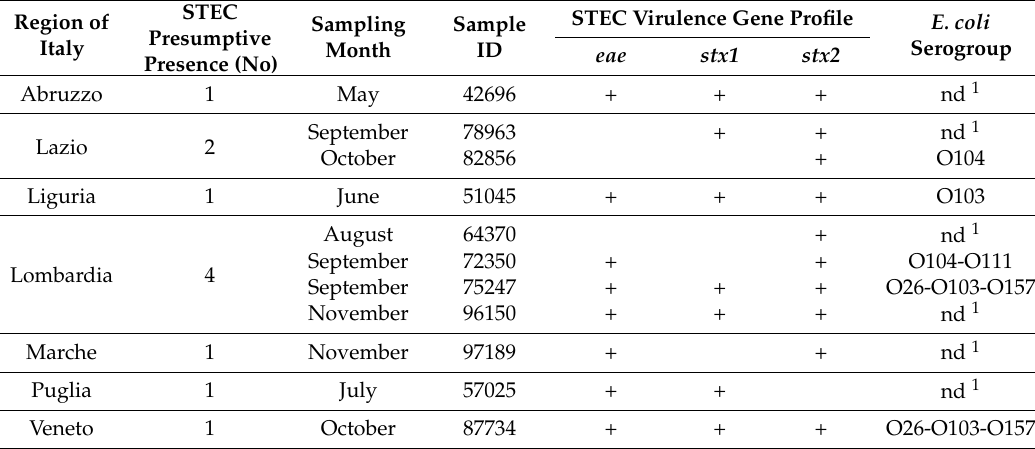
Table 1. STEC “presumptive” presence. Intimin ( eae ), Shiga-toxin stx1 and stx2 genes and serogroups detected in enrichment broth cultures obtained from fresh beef samples collected within 13 regions of Italy